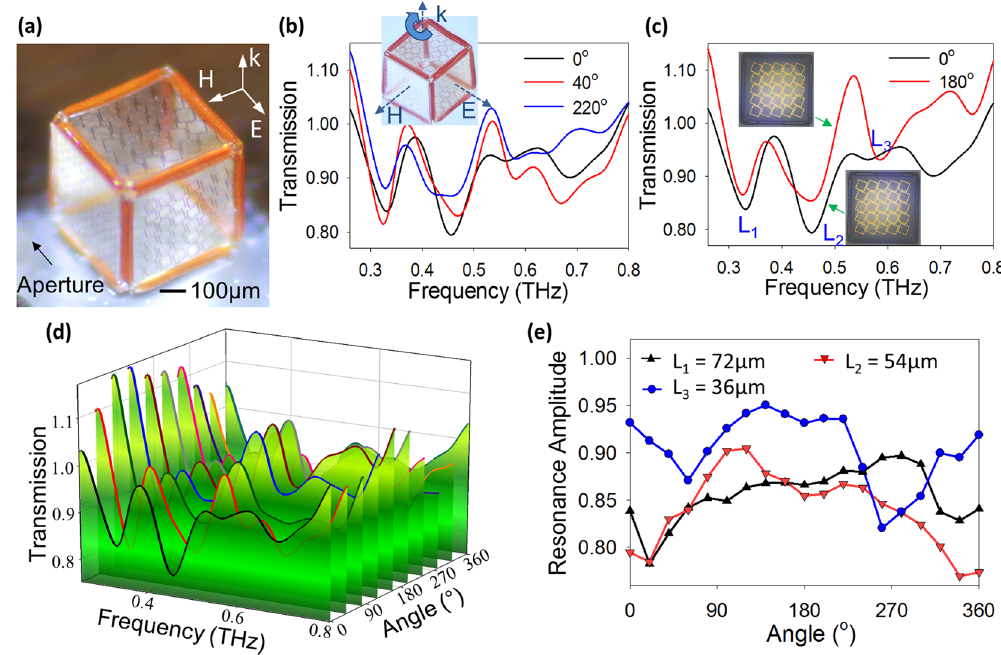
Figure 6. THz TDS measurement results for the cubic inclinometer. ( a ) Optical image of the experimental setup for THz transmission measurement, showing a 500 µ m cube placed on the circular aperture with the inset showing the polarization direction of the THz wave. ( b ) Measured transmission response displaying the ability of the cube to distinguish various angles when rotated about any axis through a change in transmission. ( c ) Measured transmission response demonstrating a clear change in transmission and breaking of the 180° isotropy of the cube. ( d ) Measured frequency spectra of the cubic structure observed while rotating the cube about the direction of wave vector (k) in steps of 40° ( e ) Measured variation in the transmission response at the fundamental resonant frequency of the 3 resonators defined on the faces of a cube when rotated along the wave vector